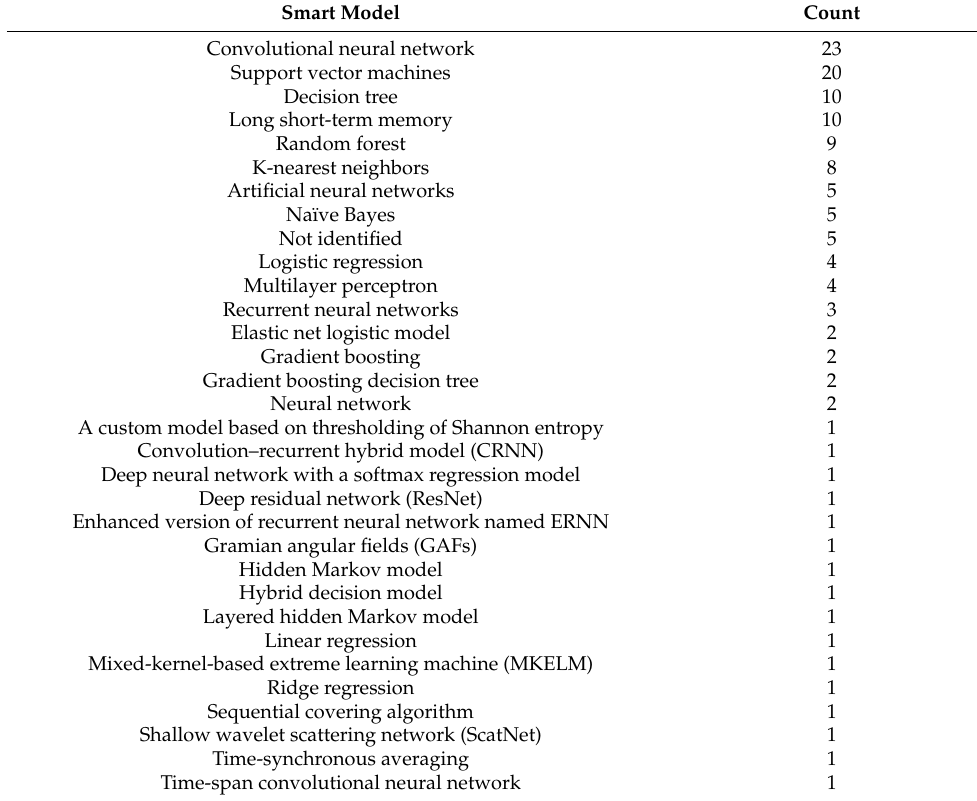
Table 4. Smart Models Used in